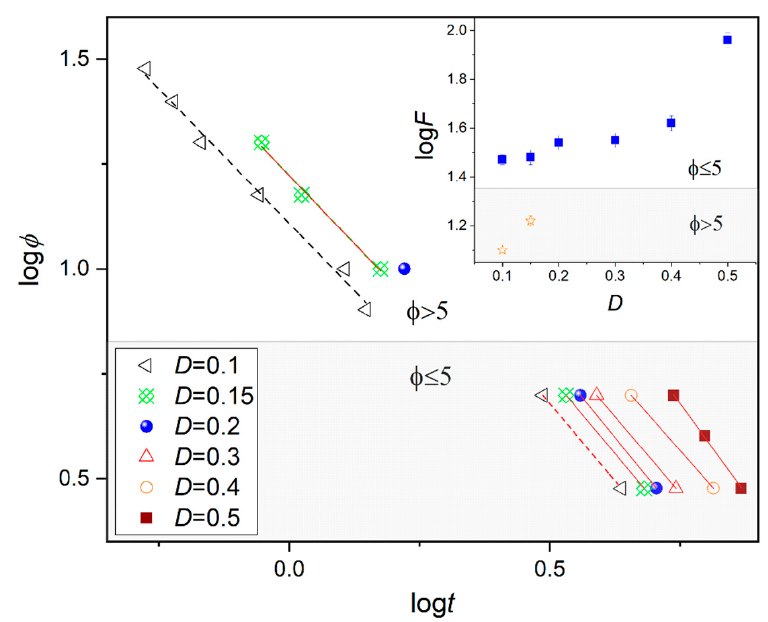
Figure 6. Plots of log φ versus logt for a selected degree of crystallinity D during non-isothermal